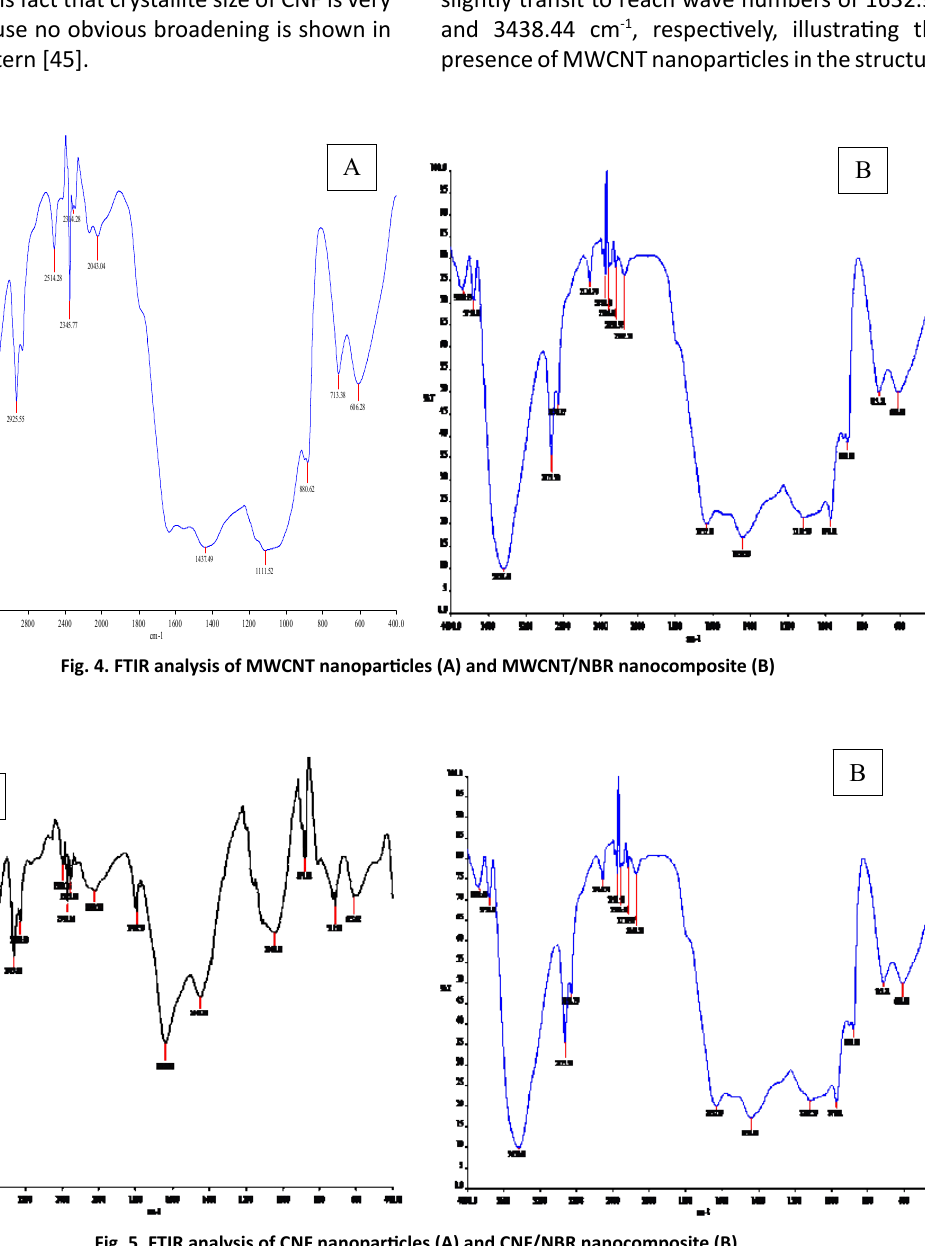
Fig. 5. FTIR analysis of CNF nanoparticles (A) and CNF/NBR nanocomposite